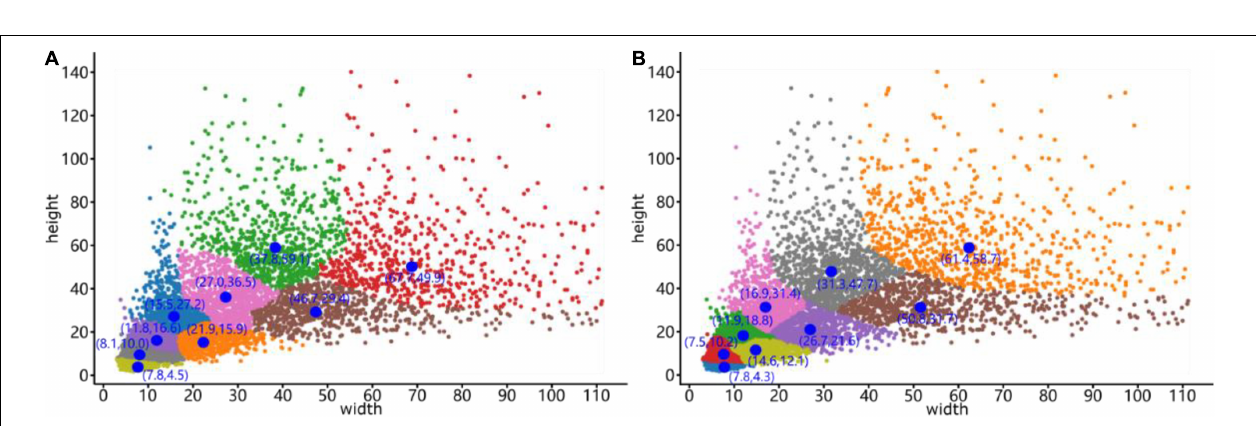
FIGURE 10 | Clustering results generated by the (A) K -means clustering algorithm and (B) Mean Shift clustering algorithm. The blue dots represent the cluster centers, and the coordinates are next to these cluster centers, while the x -coordinate is the width and the y -coordinate is the height.